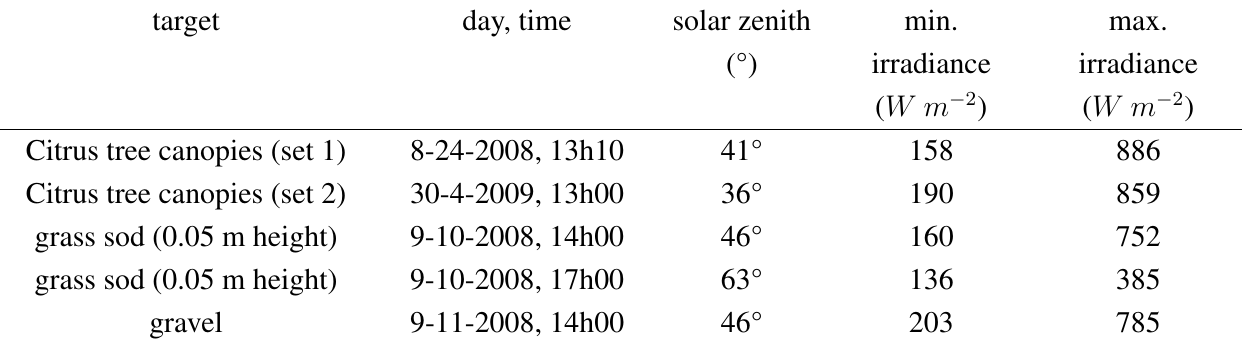
Table 2. Overview of measurement conditions and targets for field